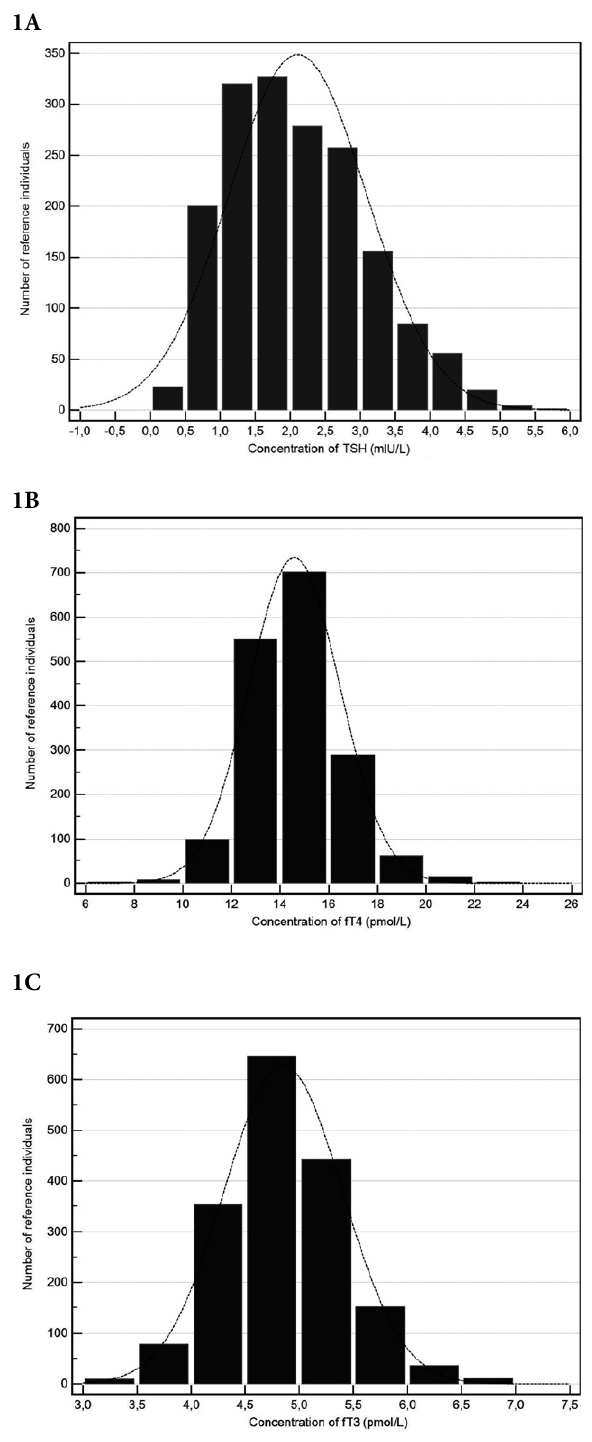
Figure 1. Histograms showing distribution of reference values in a population of 1722 reference individuals. 1A: TSH distribution of reference values with Coefficient of Skewness 0.5308 (P<0.0001) and Coefficient of Kurtosis –0.2141 (P = 0.0469); 1B: fT 4 distribu- tion of reference values with Coefficient of Skewness 0.4014 (P < 0.0001) and Coefficient of Kurtosis 0.7660 (P < 0.0001); 1C: fT 3 dis- tribution of reference values with Coefficient of Skewness 0.3044 (P < 0.0001) and Coefficient of Kurtosis 0.5839 (P =